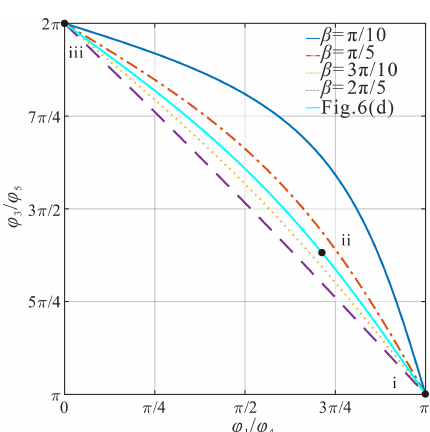
Figure 7. The kinematic curves for scheme II among upper- dihedral angles ϕ 3 ( ϕ 5 ) vs. ϕ 1 ( ϕ 4